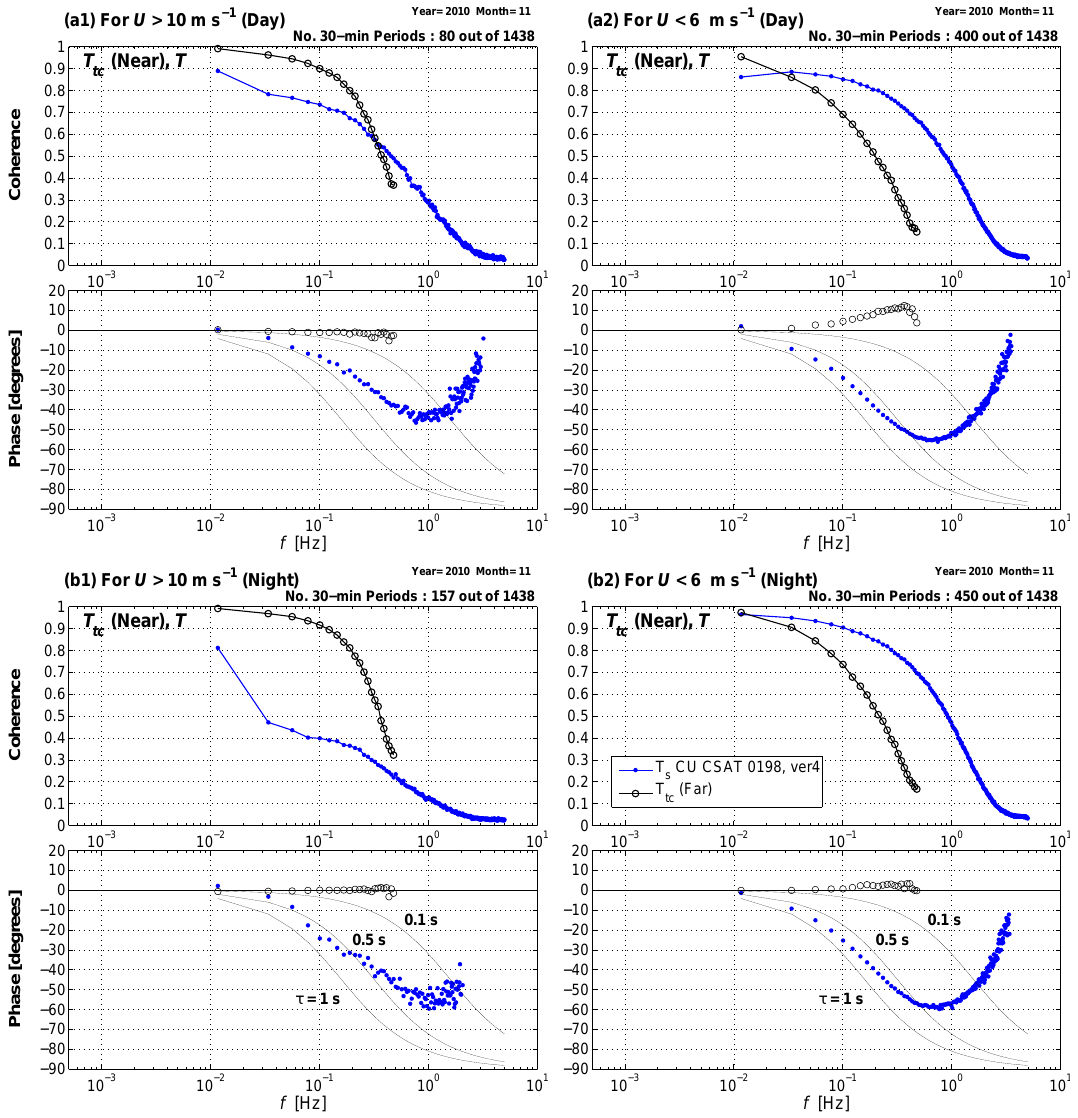
Fig. 6. As in Fig. 5, except comparing temperature from the near thermocouple ( T tc , Near) to the far thermocouple ( T tc , Far) and sonic ( T s ) temperatures as specified in the legend. The solid lines in the phase panels are the phase angles from a first-order linear differential equation with time constants of τ =1s, 0.5s, and 0.1s. To calculate the near and far thermocouple statistics, the near thermocouple 10-Hz samples are down-sampled to 1Hz by picking the 10-Hz samples closest to the 1-Hz samples in